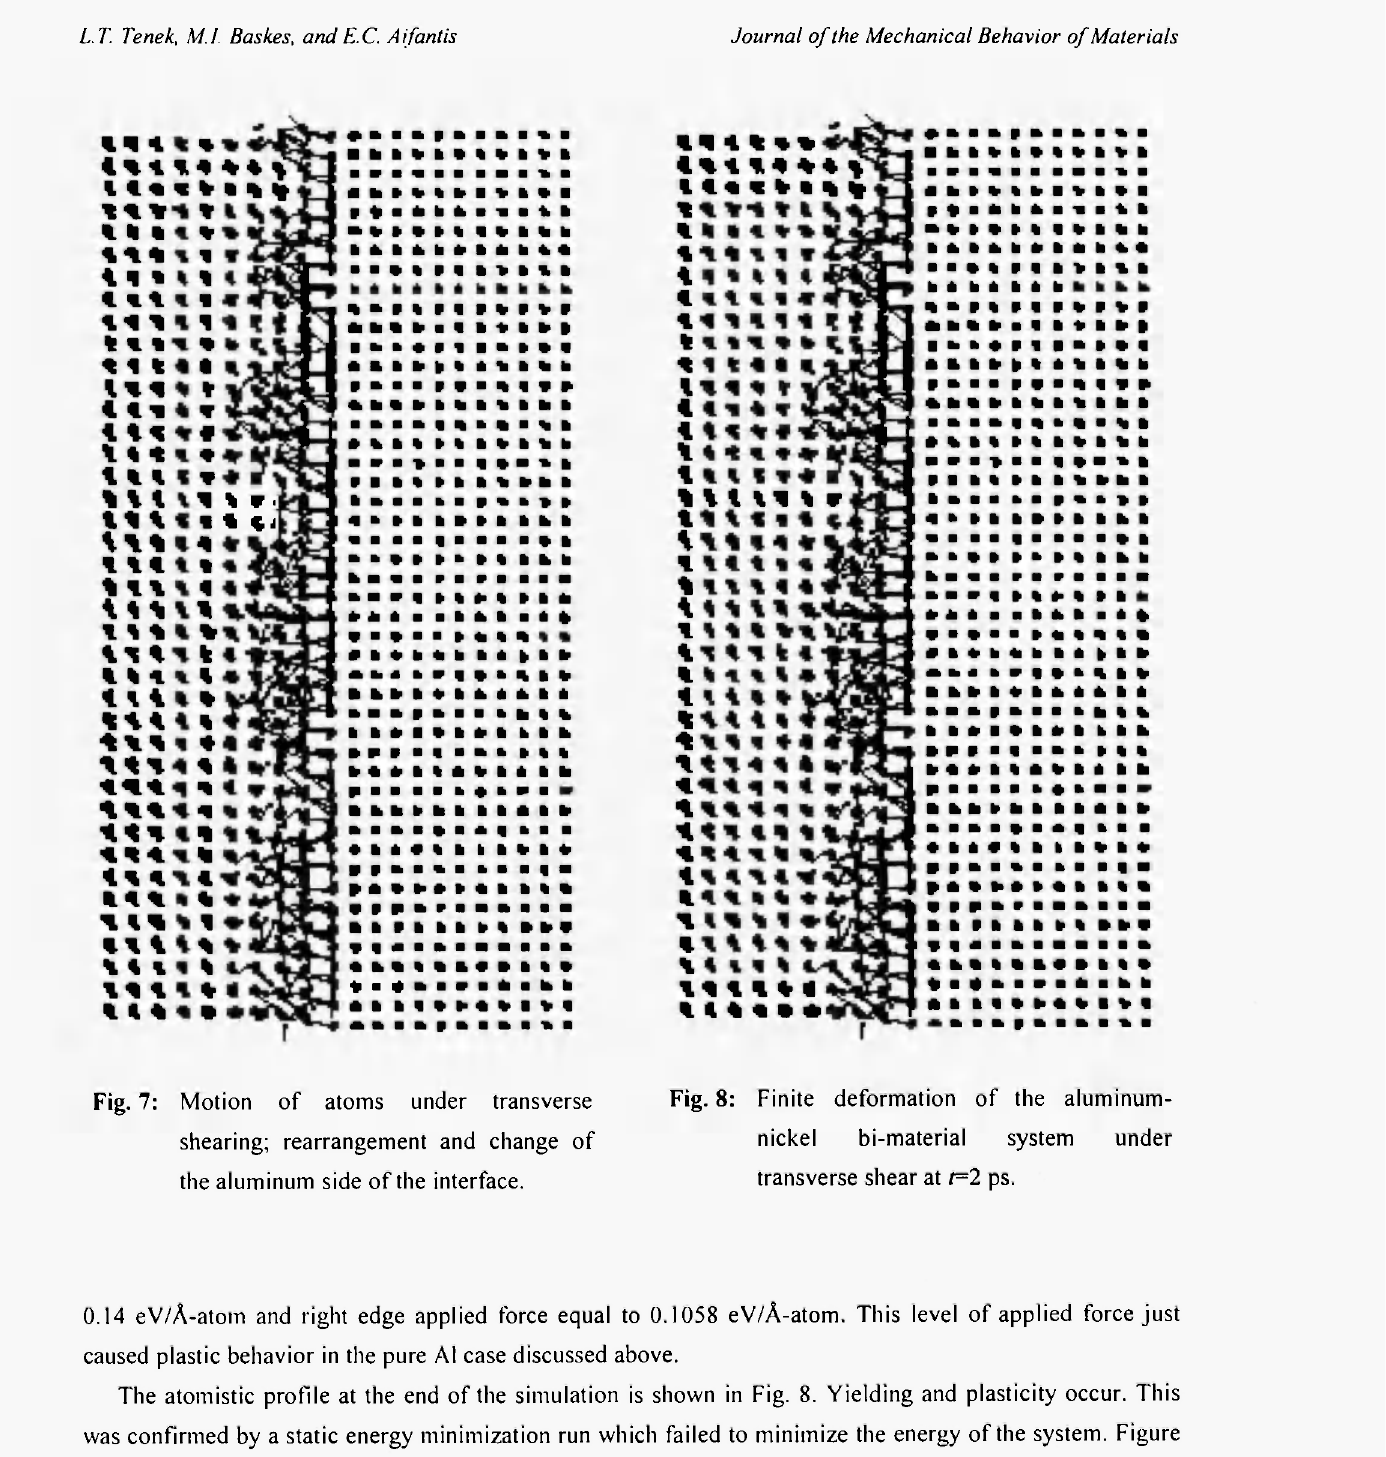
Fig. 7: Motion of atoms under transverse shearing; rearrangement and change of the aluminum side of the interface.